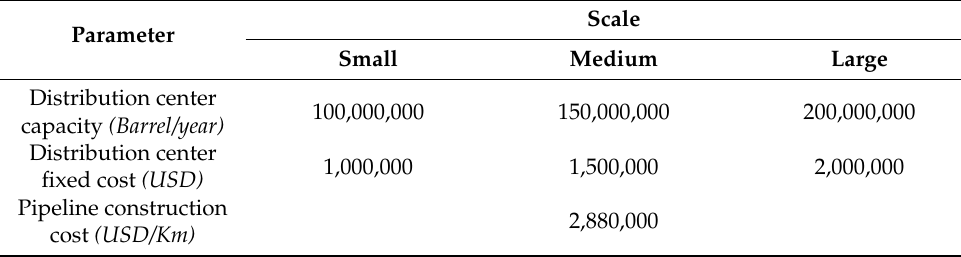
Table A4. Facility-related parameter value.